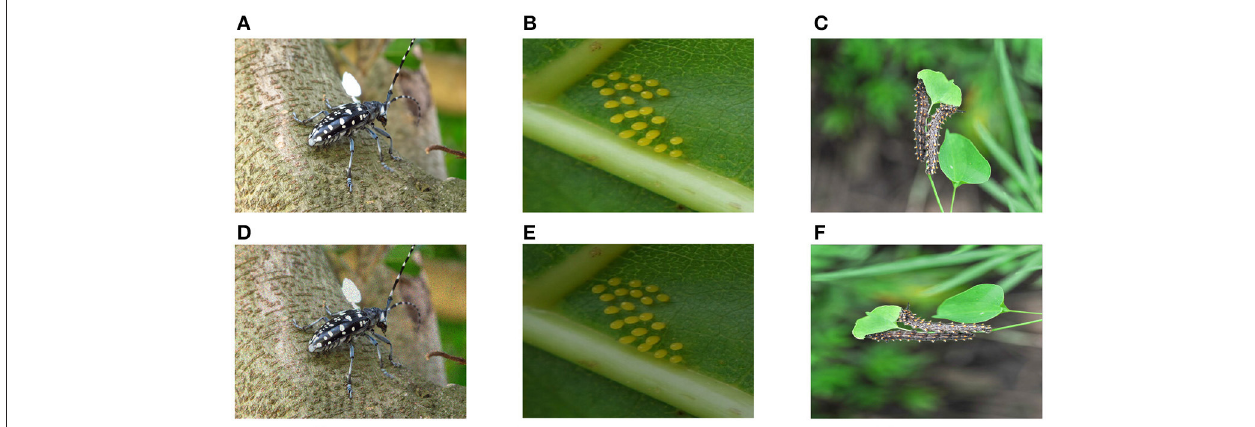
FIGURE 3 | Example of image data enhancement method. The first row is the original image, and the second row corresponds to the enhanced image. (A) Original image, (B) Original image, (C) Original image, (D) Noise, (E) Brightness transformation, and (F) Rotation.